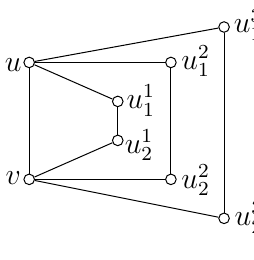
Figure 1: The book graph B (4 ,